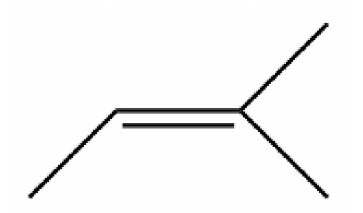
Figure 4. Molecular structure fluxes of EUG.